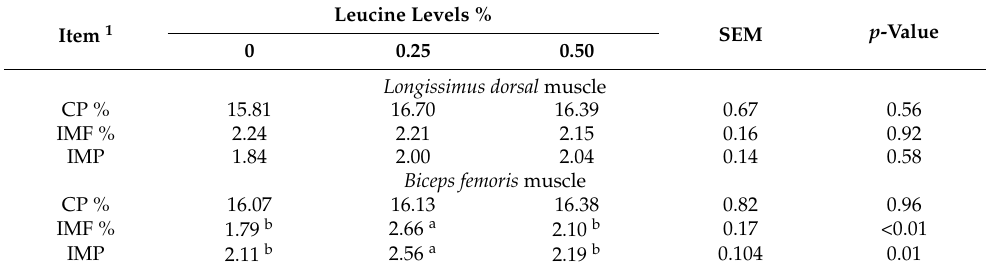
Table 6. Effects of dietary leucine on chemical composition of the muscle tissue.